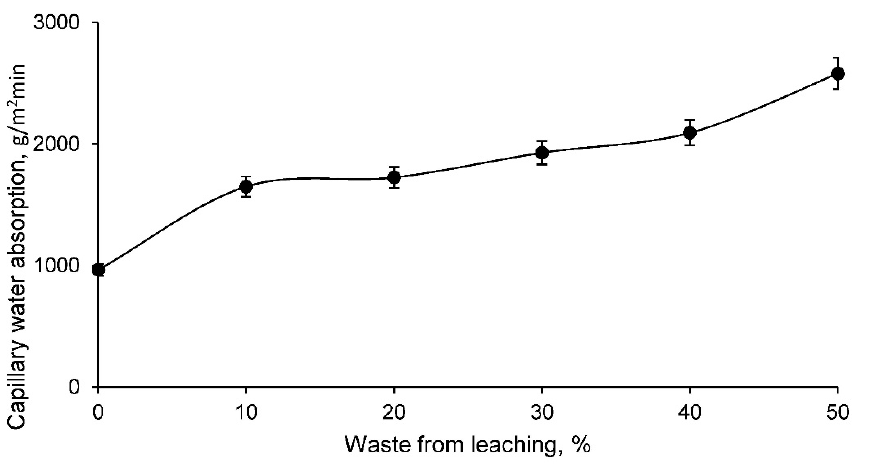
Figure 6. Capillary water absorption of different families of clay-conformed ceramics and leaching residue.